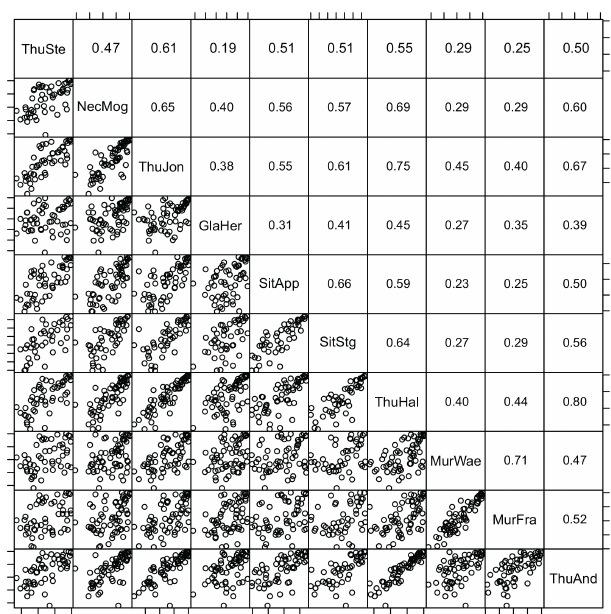
Figure 3. Pairs plot (lower triangular matrix) and Kendall’s corre- lation coefficients (upper triangular matrix) of regional peak-over- threshold events. The stations are labeled with their abbreviations listed in Table 1. Patterns of positive association are visible in all